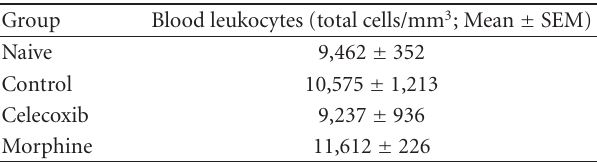
Table 1: Leukocyte number in blood collected from untreated control and treated periodontal-diseased rats.